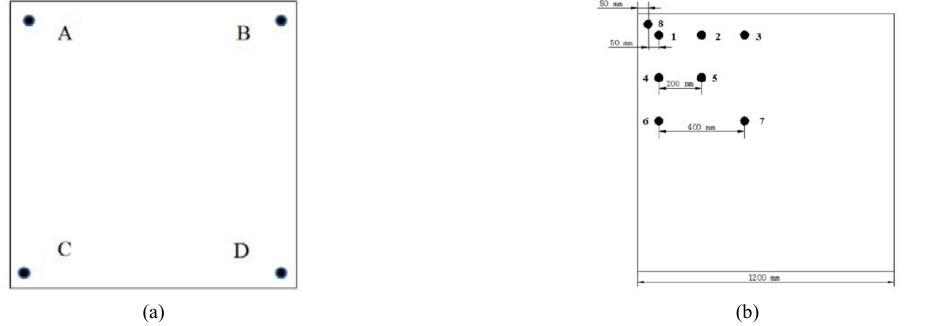
Fig. 10 (a) An illustation of the four-point fixed glass setup and (b) an illustation of the eight different point-fixing locations of point-fixing A (Wang 2019).